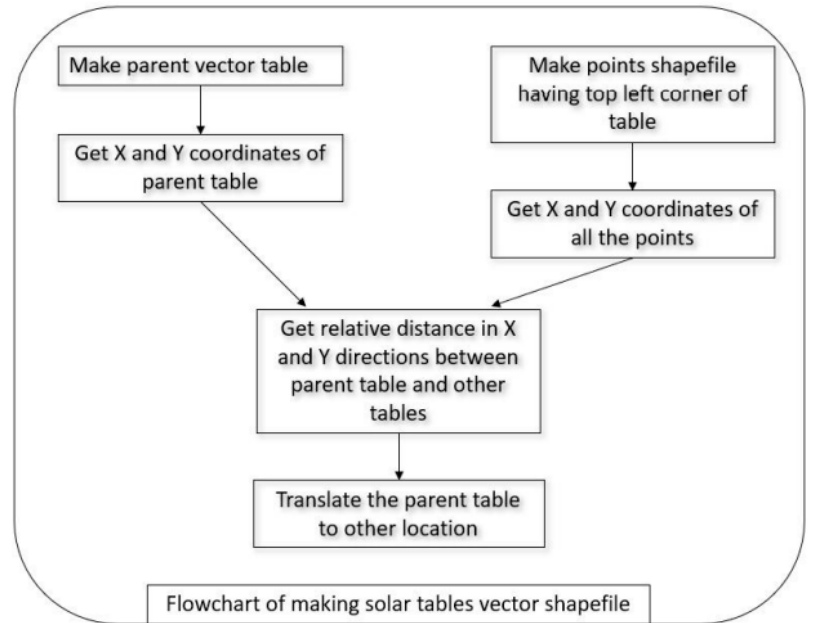
Figure 3. Flowchart of making solar tables vector shape file.